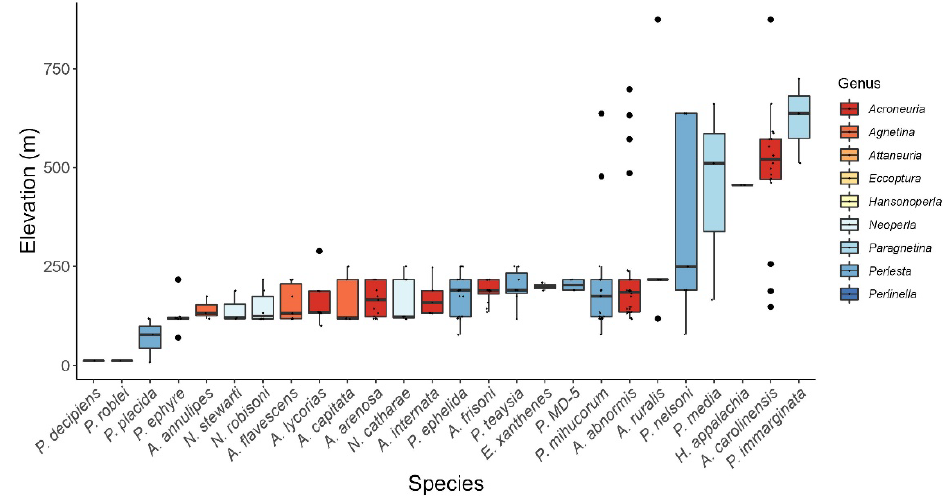
Figure 12. Elevation boxplots for Perlidae species recorded from Maryland. Boxes represent the